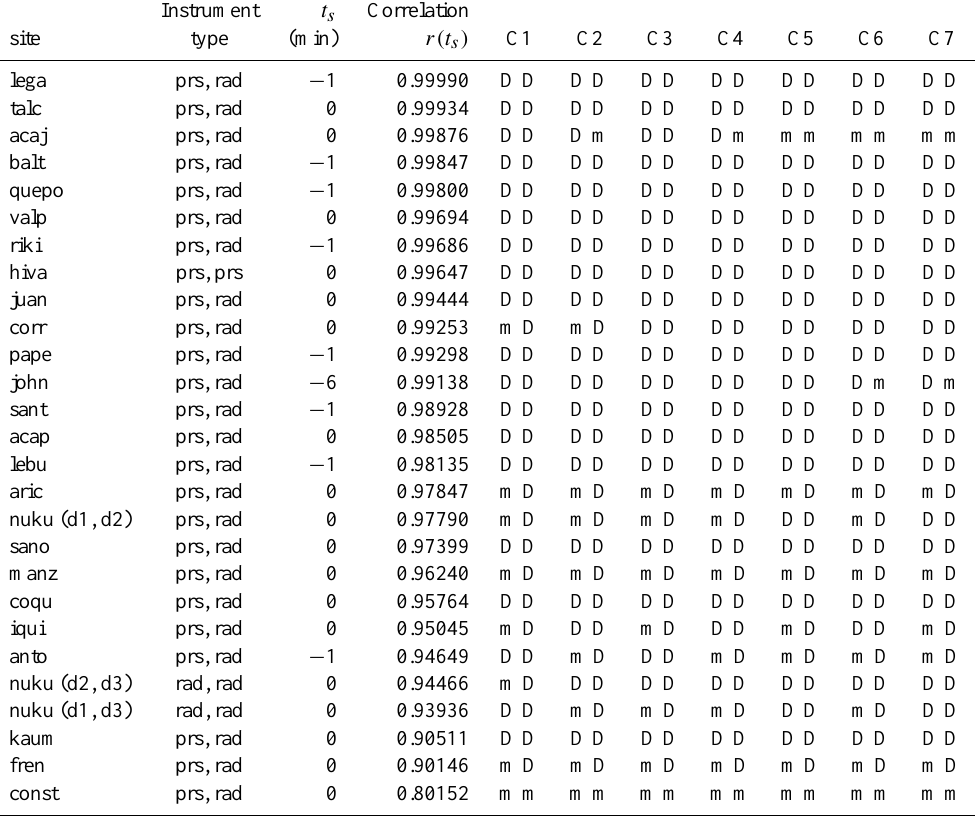
Table 5. Detections for stations with multiple records. For each station pair, we report the type of instruments installed; the time shift t s of the first series with respect to the second of the pair corresponding to the maximum cross-correlation coefficient r as well as the maximum cross-correlation coefficient itself. Moreover, for every configuration, results of detections are given with a couple of letters, one for each record. When not explicitly given, the first letter refers to channel 1 and the second to channel 2. The letter D is used to mean “detection” and the letter m to mean “missed detection”. Notice that stations are sorted by decreasing values of the correlation coefficient. Out of the total of 175 combinations resulting from 25 pairs of channels analysed with 7 configurations, detection discrepancies occur in 46 cases, which is about